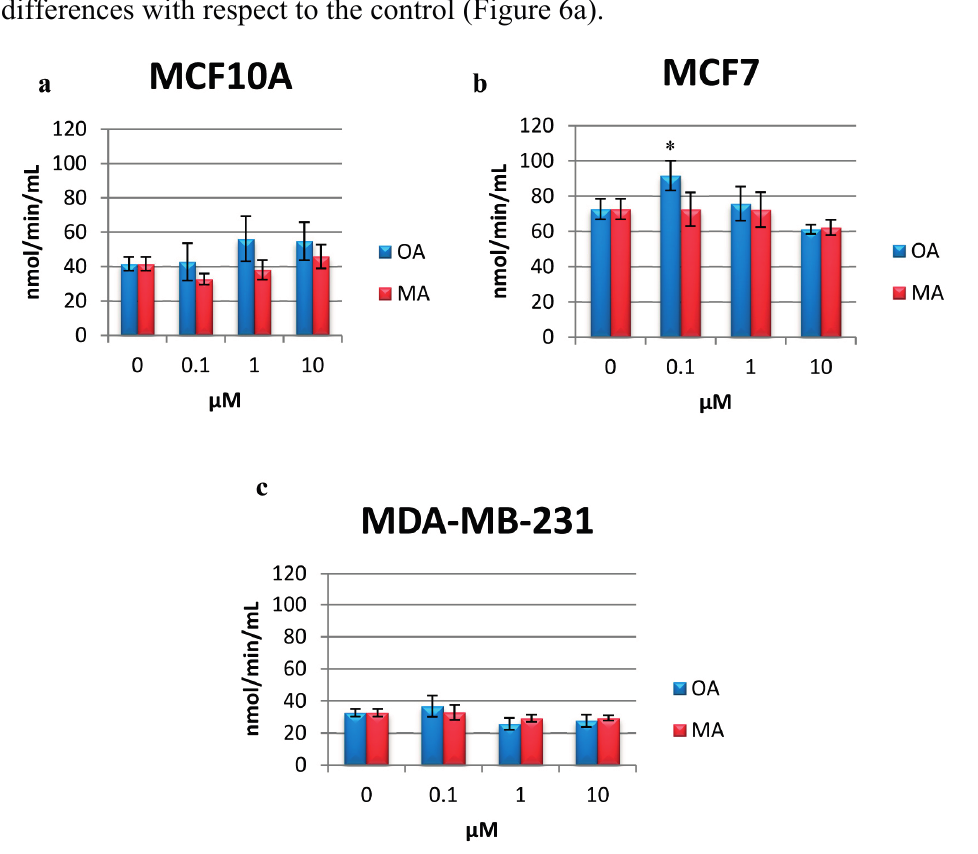
Figure 6. CAT activity in MCF10A cells ( a ); MCF 7 cells ( b ) and MDA-MB-231 cells ( c ) treated with OA or MA at 0.1 µM, 1 µM and 10 µM for 4 h. Values represent the mean ± SEM of three independent experiments. Statistically significant differences are represented by (*) for OA at p < 0.05 with respect to the untreated